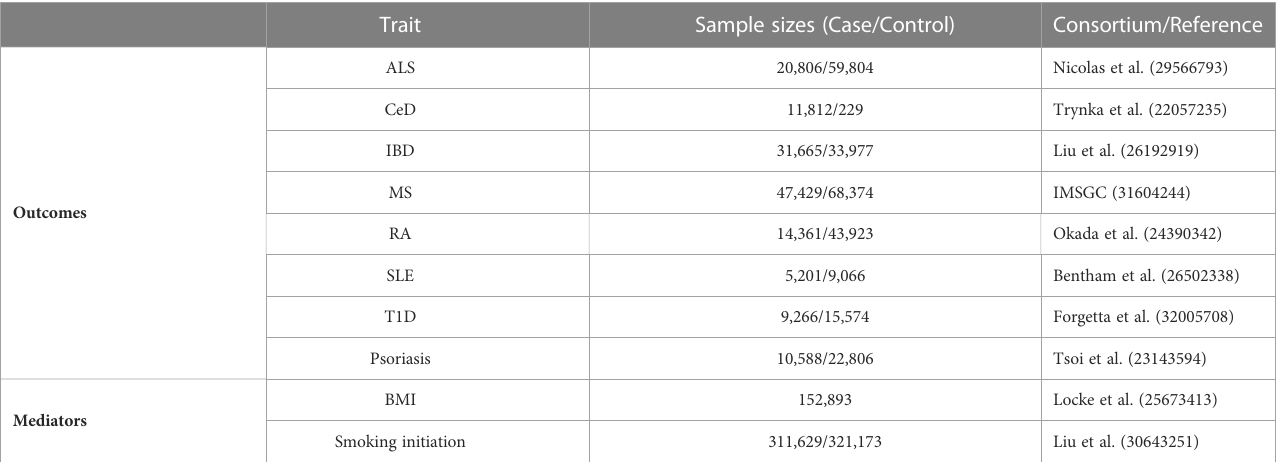
TABLE 2 Details of GWAS studies for AIDs traits and Mediators.